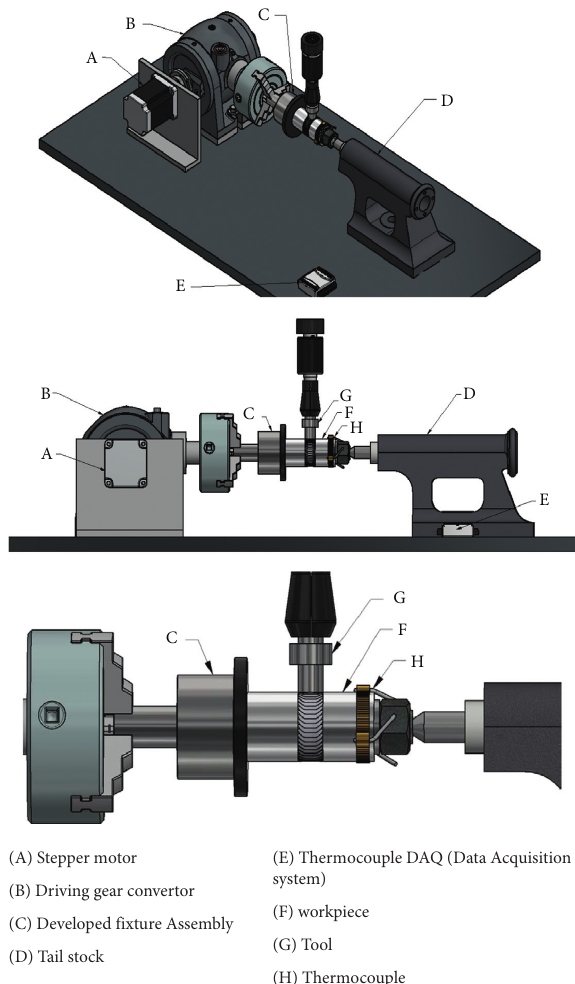
Figure 1: Friction stir welding components and mechanism of welding.